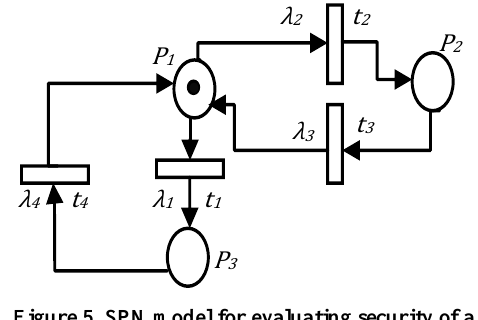
Figure 5. SPN model for evaluating security of a component.